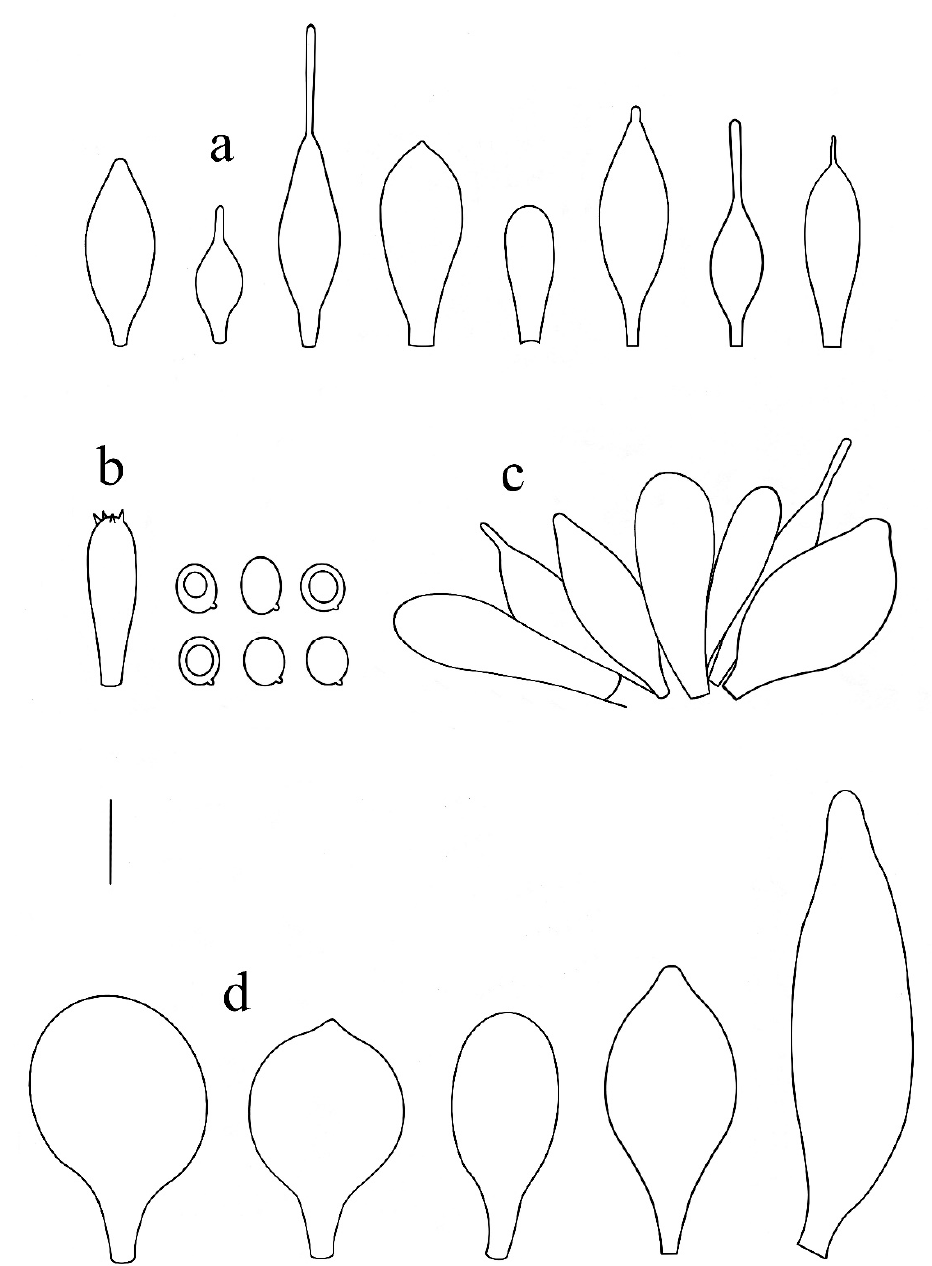
Figure 12. Pluteus reisneri holotype PRC, Velenovský herbarium, bottle 135: ( a ) cheilocystidia; ( b ) basidium and spores; ( c ) caulocystidia; ( d ) pileipellis elements. Scale bar 10 µm.